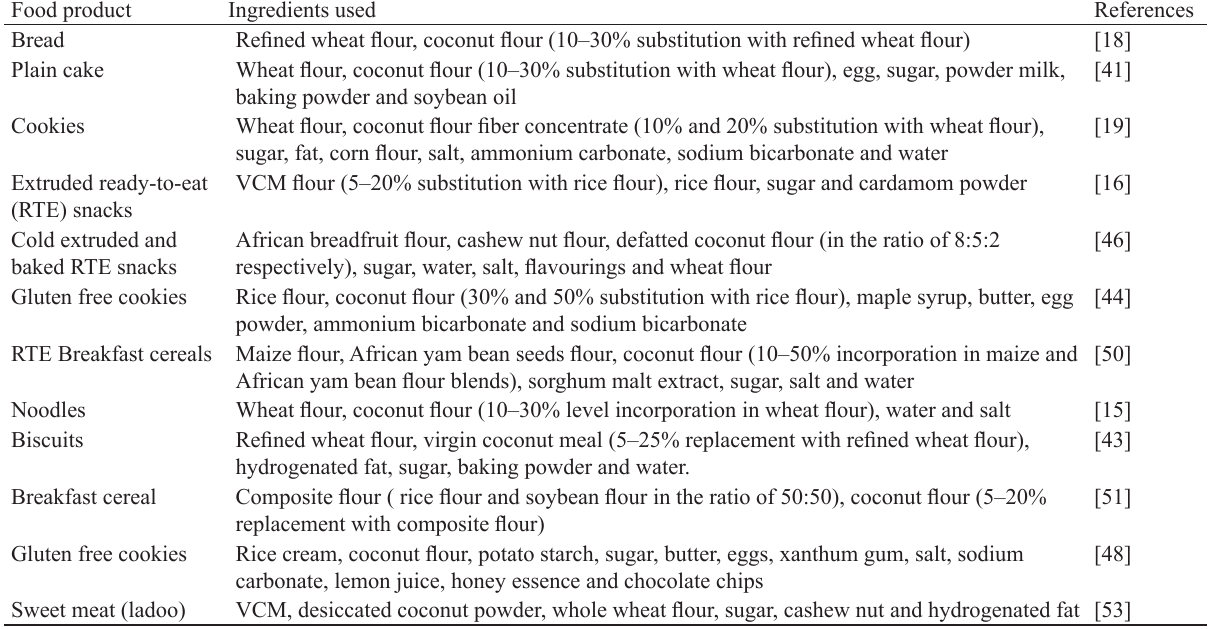
Table 3 Coconut flour food products Food product Ingredients used